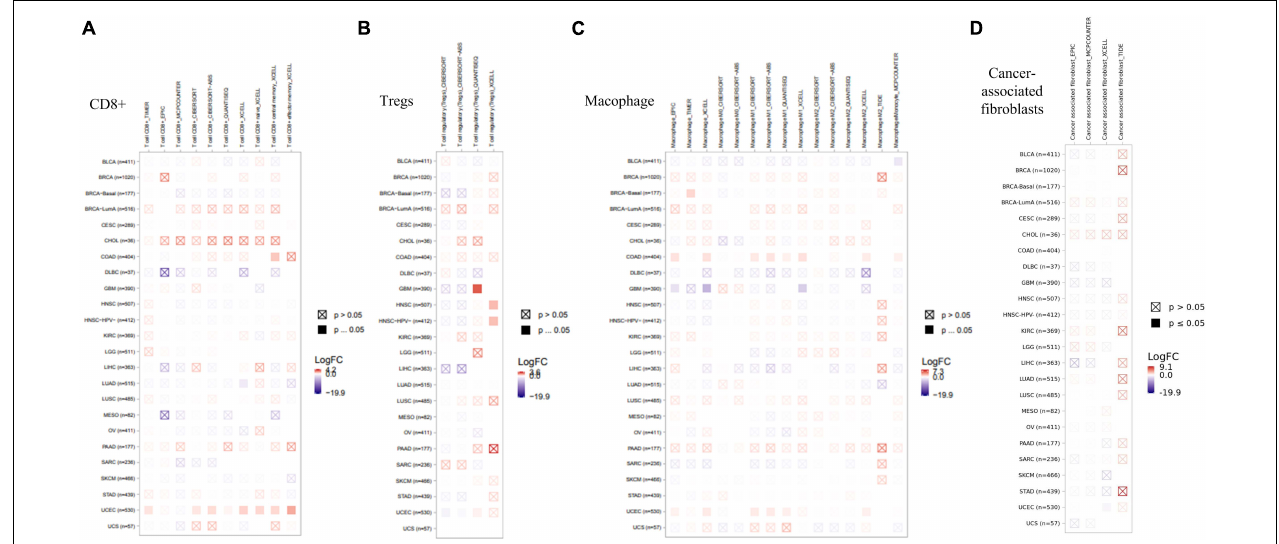
FIGURE 9 | Correlation analysis between EZH2 expression and immune infiltration of (A) CD8 + , (B) Tregs, (C) Macophage, (D) Cancer-associated fibroblasts.